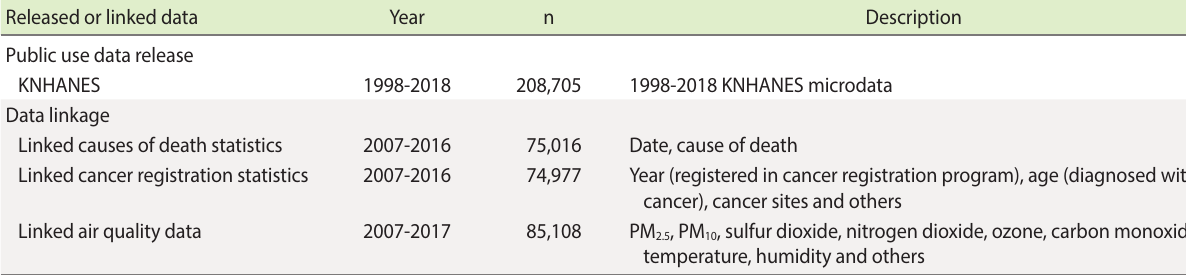
Table 4. Data release and linkage of Korea National Health and Nutrition Examination Survey (KNHANES) Released or linked data Year